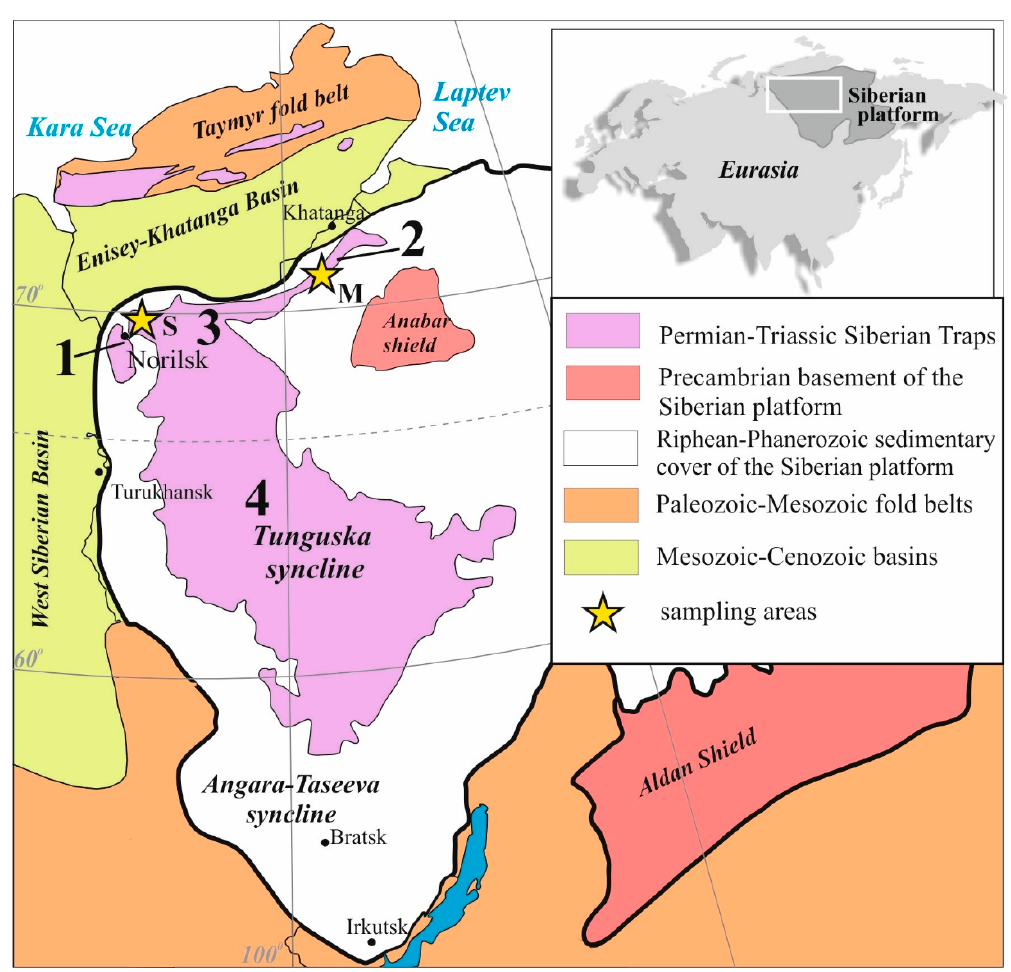
Figure 1. Geological scheme of the Siberian platform. Regions of the Siberian Traps LIP: 1—Norilsk; 2—Maymecha-Kotuy; 3—Putorana; 4—Nizhnyaya Tunguska. Sampling areas: S—Samoedsky Formation; M—Maymecha river valley.